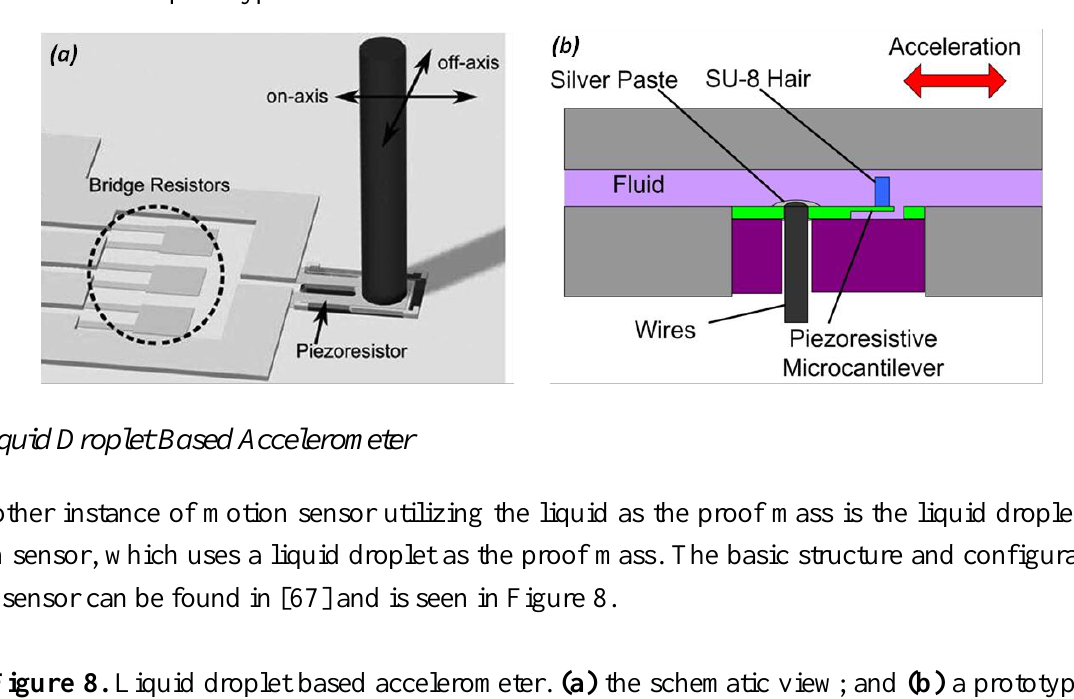
Figure 7. Artificial hair cell sensor. (a) the schematic view; and (b) the cross sectional schematic of a prototype.